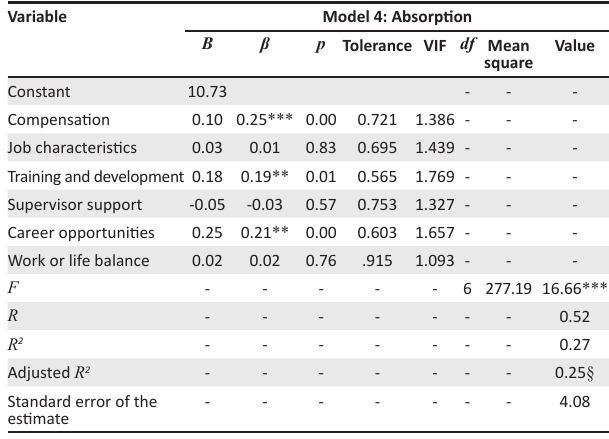
TABLE 7: Multiple regression analysis: Retention Factors Measurement Scale as a predictor of absorption ( N = 278).